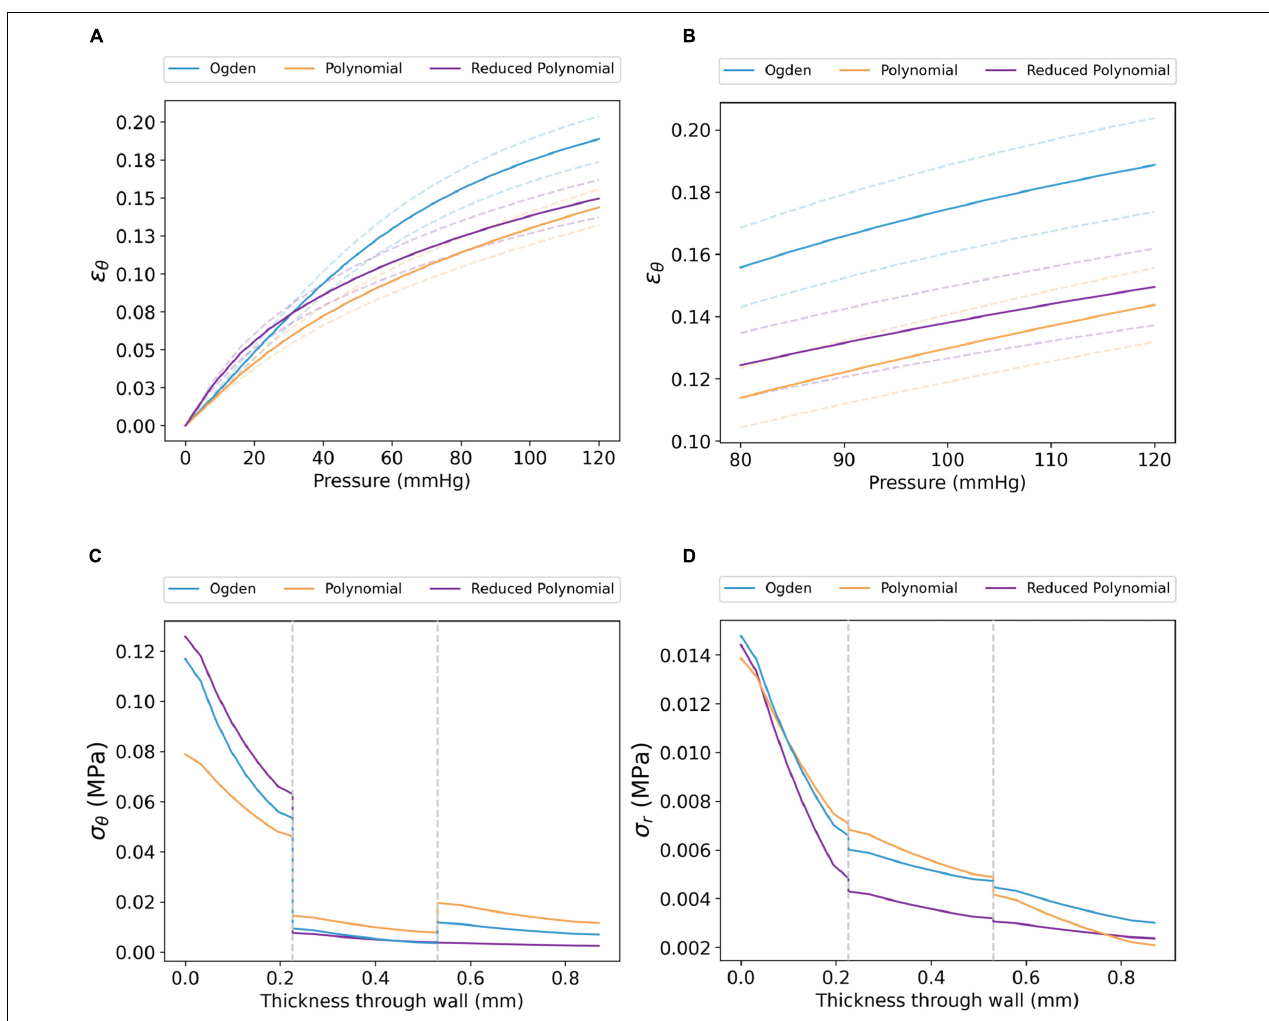
FIGURE 5 | Transmural biomechanics of the coronary artery using the Ogden, polynomial and reduced polynomial hyperelastic parameters listed in Table 2 . The mean (cid:101) θ of the coronary intima between (A) 0–120 and (B) 80–120 mmHg pressure (dashed lines show the S.D. for each model). Similar trends were observed for (cid:101) θ , media , (cid:101) θ , adventitia , (cid:101) r , intima , (cid:101) r , media and (cid:101) r , adventitia ; for these, the reader is referred to Supplementary Figures 3–5 . (C) σ θ and (D) σ r profiles for each model through the radial thickness of the artery wall, extracted at systolic pressure. Grey dashed lines represent the intima–media and media–adventitia interfaces.